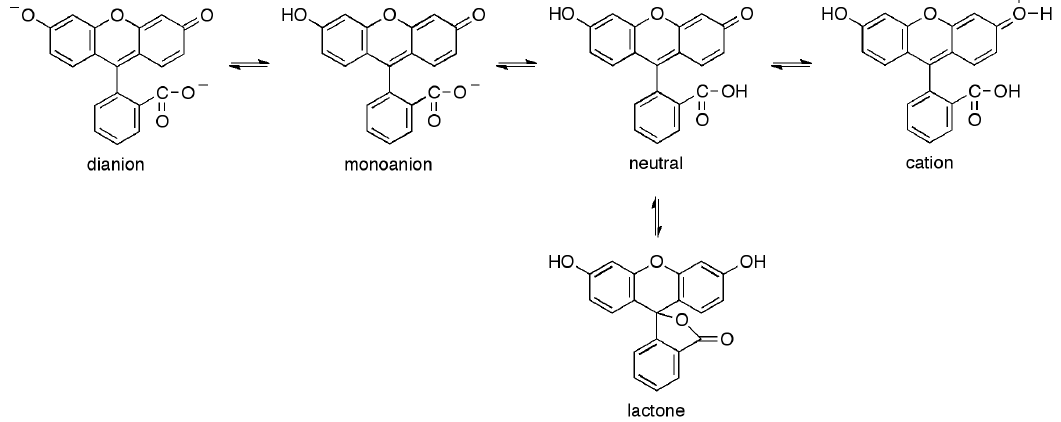
Figure 1. Ionization equilibria of